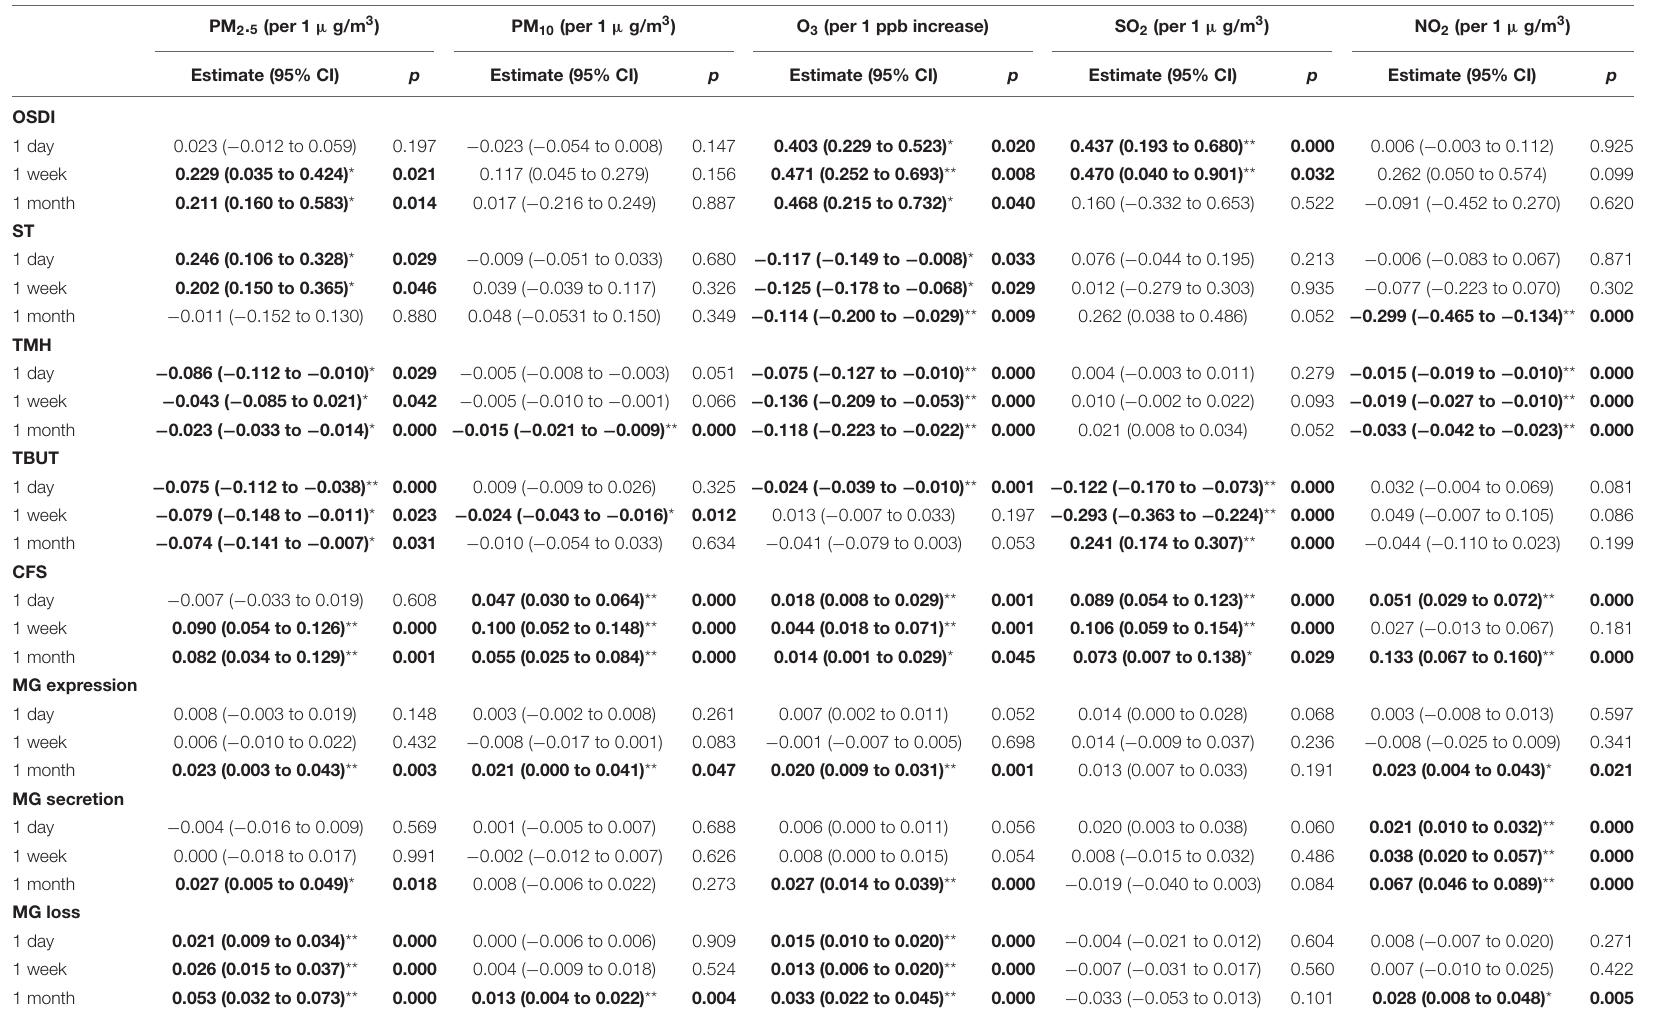
TABLE 4 | Effects of air pollutants on ocular surface using multi-pollutant